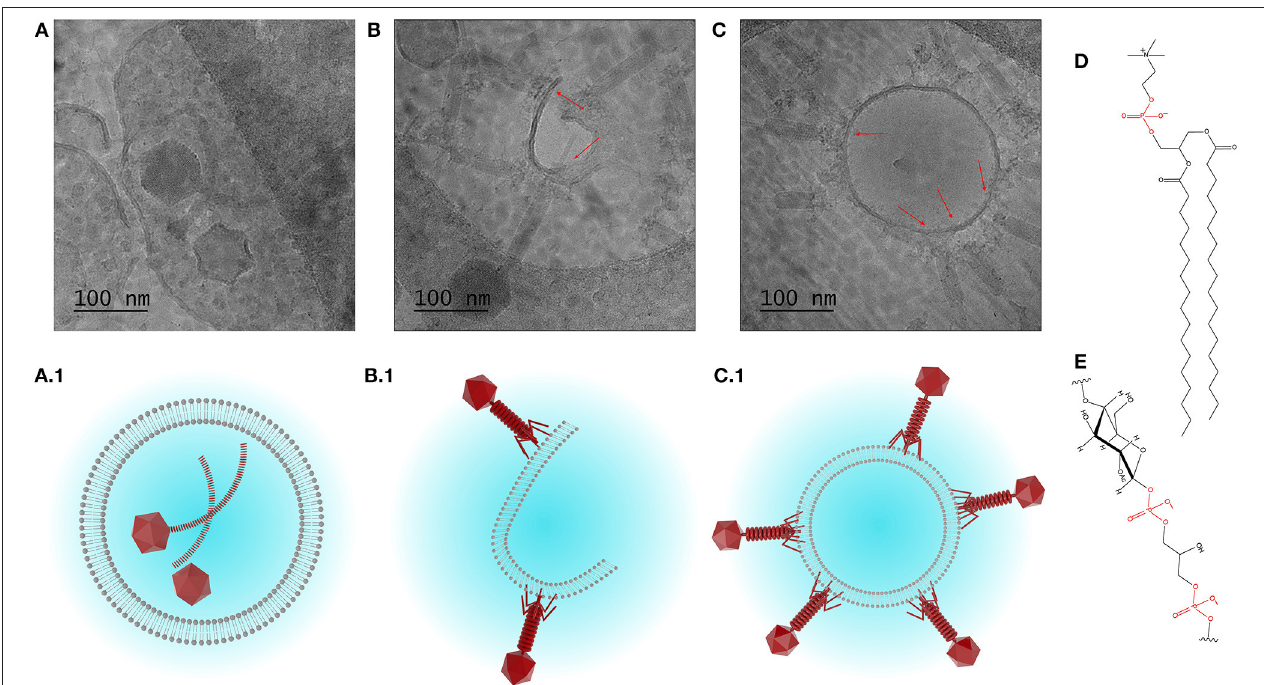
FIGURE 4 | Cryo-TEM images showing (A) encapsulation of phage K, and (B,C) interaction between phage K tails and the outer leaflet of the bilayer membrane of formed liposomes (DSPC:cholesterol molar ratio was 5:1), some tails look contracted. (A1–C1) Schematized depiction showing encapsulation of phage K within the liposome (favored outcome) and interaction of phage K with the outer surface of unilamellar liposome membrane and lipid bilayer (unfavorable outcome). (D) Chemical structure of DSPC and (E) chemical structure of teichoic acid (phosphate groups highlighted in